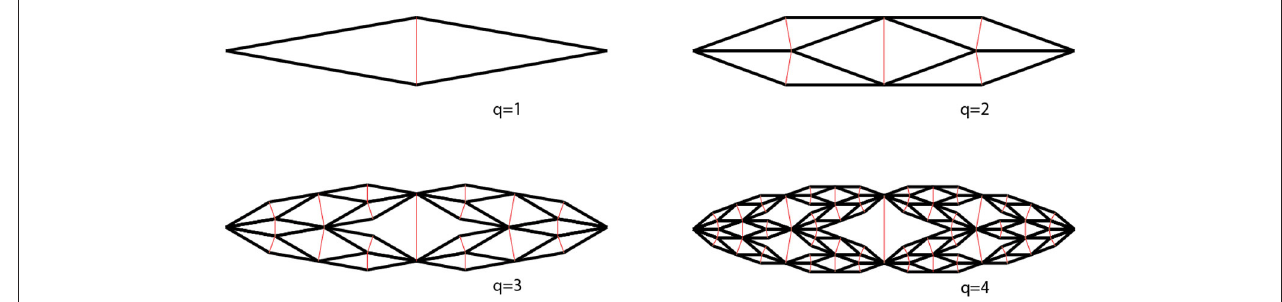
FIGURE 3 | Configurations of the planar D-Bar Self-Similar structure with constant α